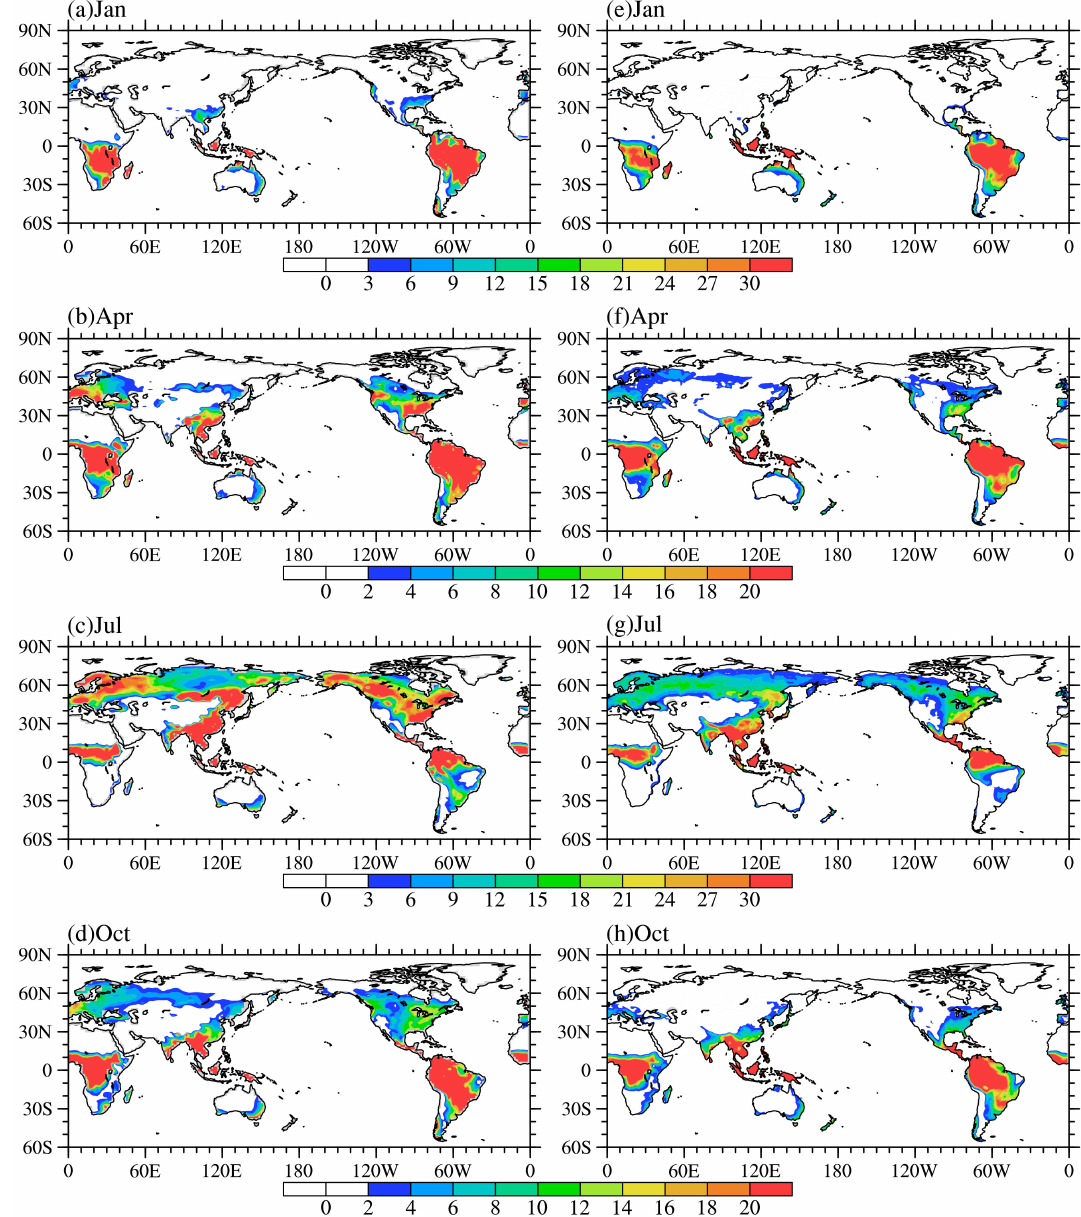
Figure 3. Spatial distribution of global Ec (units: W/m 2 ): ( a – d ) NOAA reanalysis data and ( e – h ) simulated by